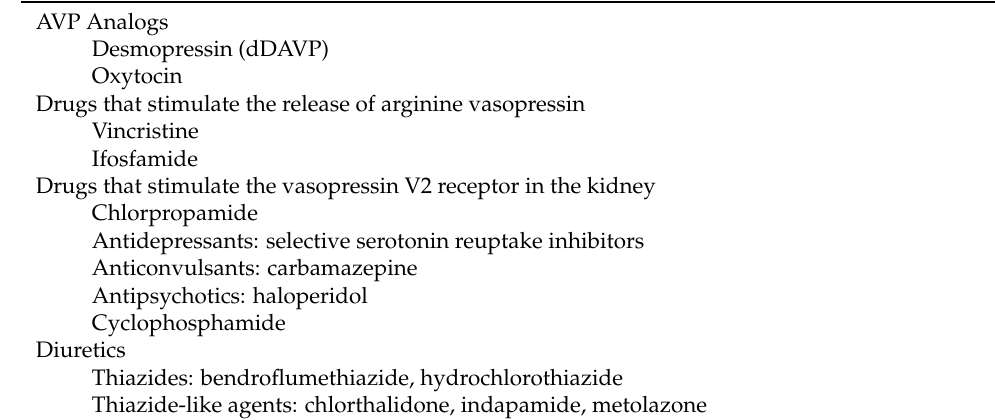
Table 1. Major drugs that can cause